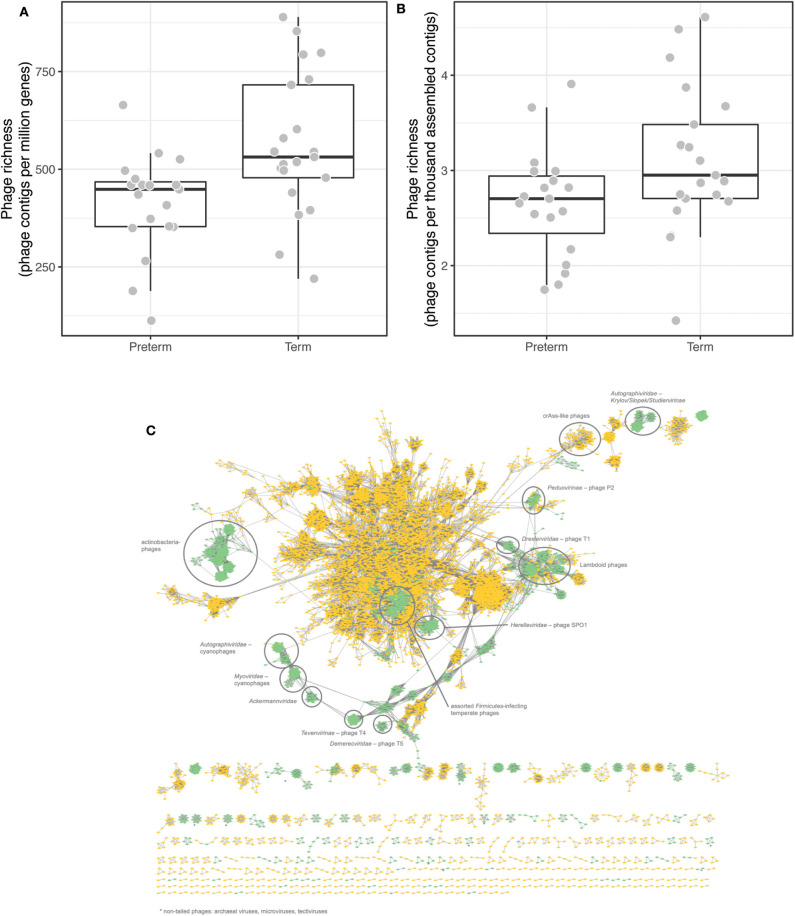
Gut phage richness differed between children born preterm or term. (A) Phage richness measured by the number assembled partial phage genomes per million genes; mean values 412 and 536 partial phage genomes per million genes in children born preterm and term, respectively. (B) Phage richness measured per thousand assembled contigs; mean values 2.66 and 3.11 partial phage genomes per thousand assembled contigs. (C) Gene-sharing network of assembled phage genomes (from all 41 individuals in the subgroup of this study) and reference genomes from Viral RefSeq v94 annotated with selected members of a subset of clusters. Reference genomes are in green, partial phage genomes from this study in yellow.